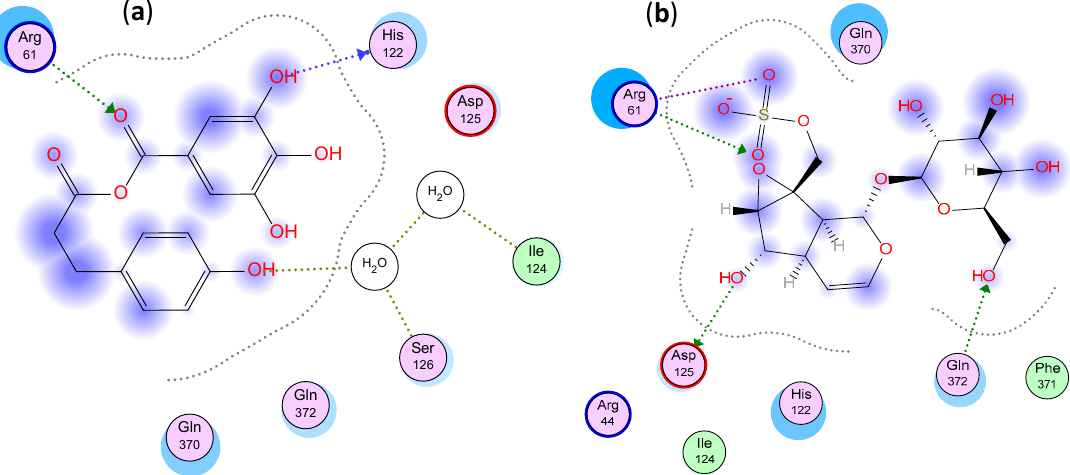
Figure 6. Two-dimensional interactions of ( a ) phloretic acid gallate and ( b ) catalpol sulphate with COX-2.